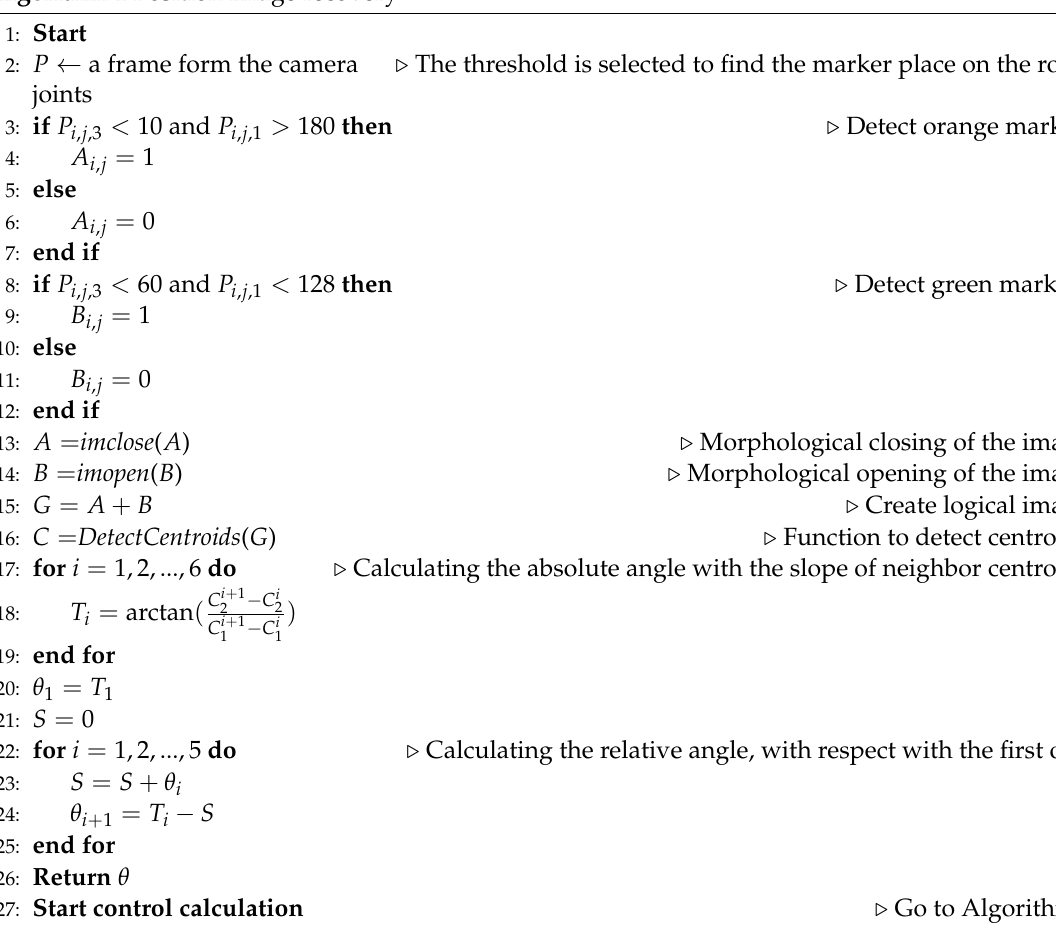
Algorithm 1 Position image recovery